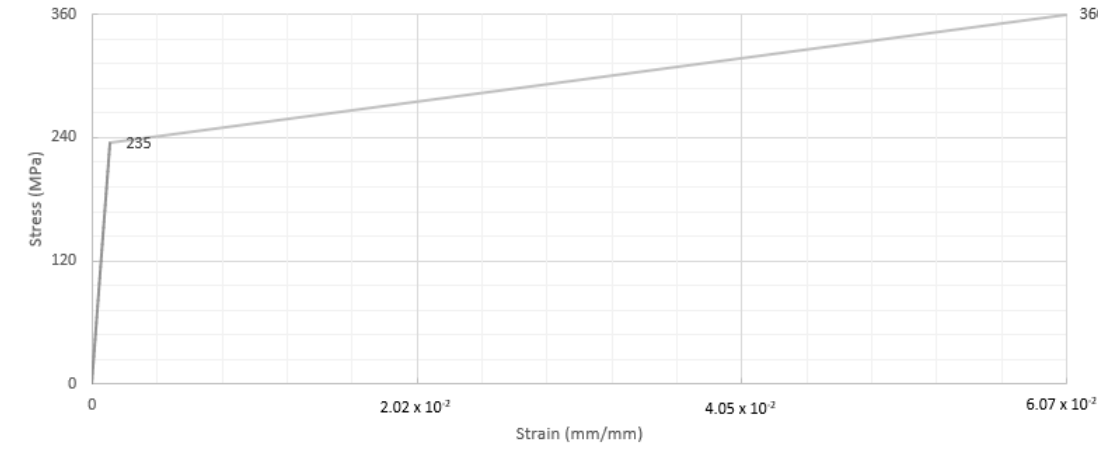
Figure 4. Linear-elastic stress–strain behavior.